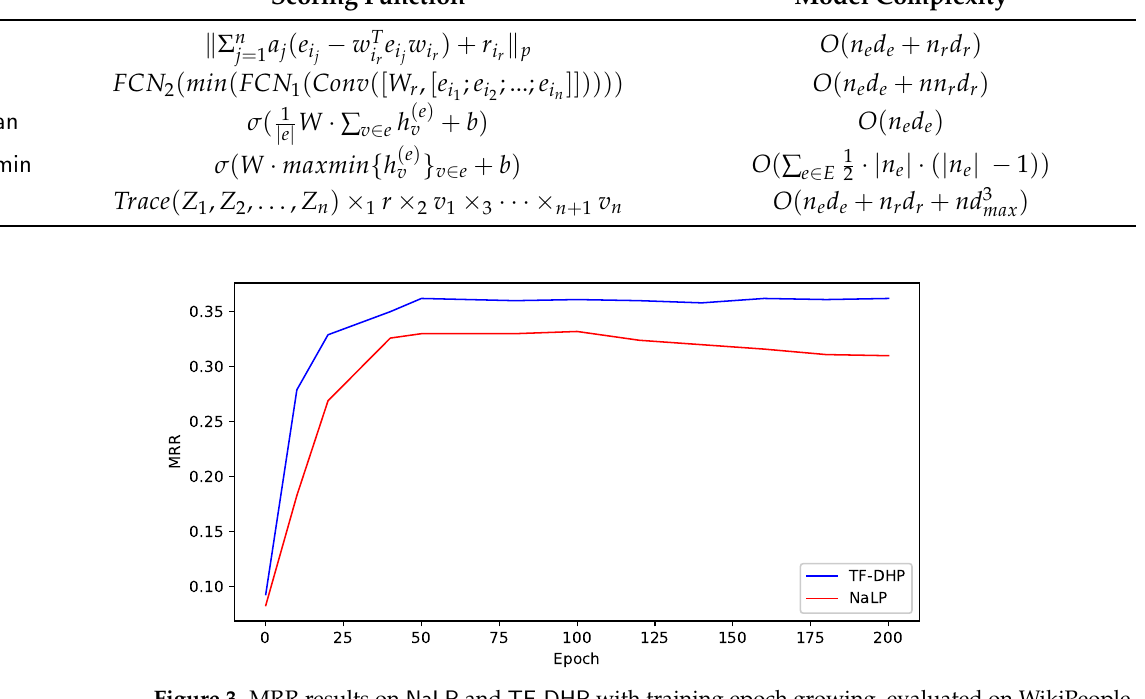
Figure 3. MRR results on NaLP and TF-DHP with training epoch growing, evaluated on